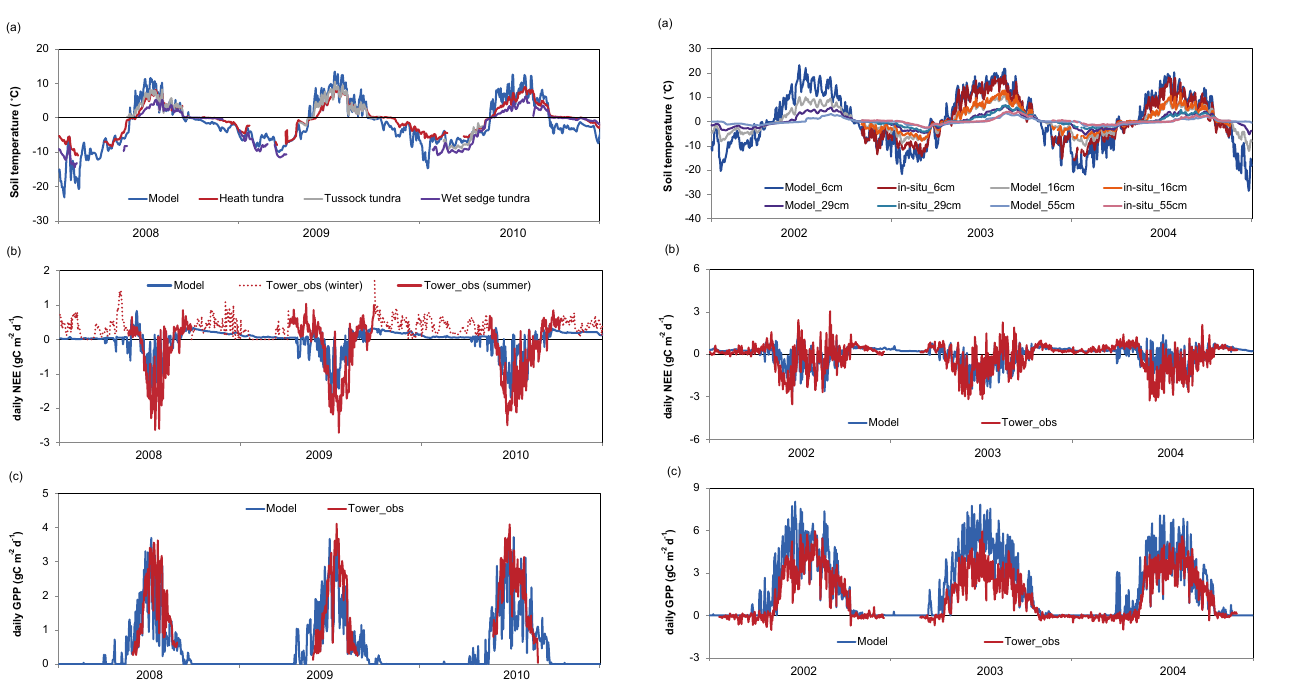
Figure 1. Comparisons of model-simulated (a) surface soil temper- ature ( ∼ 5cm depth) and carbon fluxes ( b : NEE; c : GPP) and tower measurements at the Imnavait Creek, Alaska, tundra sites over a 3- year (2008–2010) daily record. The tower-observed carbon fluxes were averaged across three tundra community types, including dry heath, moist acidic tussock and wet sedge tundra except for the NEE measurements during the winter. NEE measurements were not col- lected at the tussock tundra site during the winter; therefore, the winter NEE measurements were averaged for the dry heath and wet sedge tundra sites only.